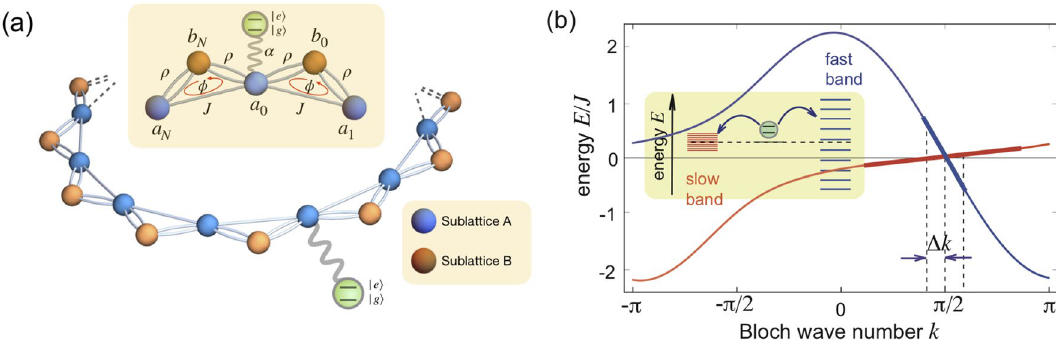
Figure 1. (color online) ( a ) Schematic of a two-level quantum emitter decaying on a chiral sawtooth photonic lattice. The lattice comprises two sublattices A and B, with hopping constants J and ρ (represented by single and double lines), on a ring geometry. A synthetic magnetic flux φ is applied in each plaquette of the lattice (see the inset). ( b ) Energy diagram (dispersion curves) of the bipartite ring lattice for ρ/ J